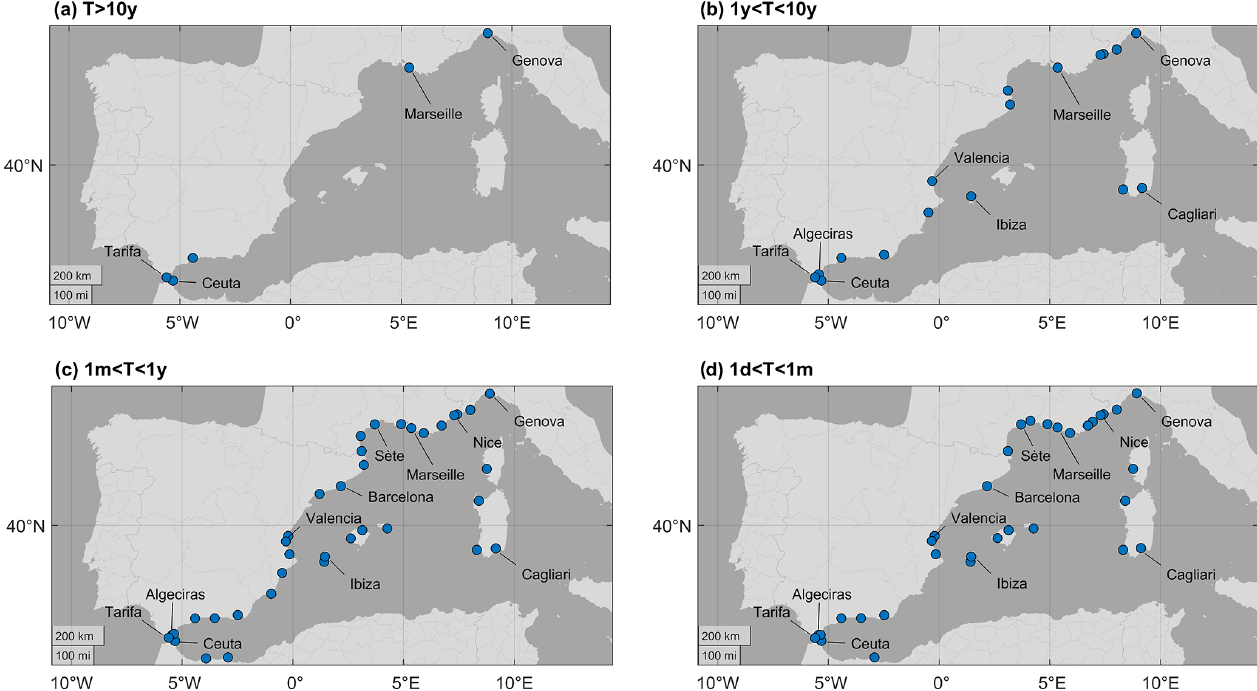
Figure 1. Maps of the tide gauges selected in each band. (a) PSMSL tide gauges used in the reconstruction for the frequency band below 10 years. (b) PSMSL tide gauges used in the reconstruction for the frequency band between 1 and 10 years. (c) PSMSL tide gauges used in the reconstruction for the frequency band between 1 month and 1 year. (d) GESLA-2 tide gauges used in the reconstruction for the frequency band between 1d and 1